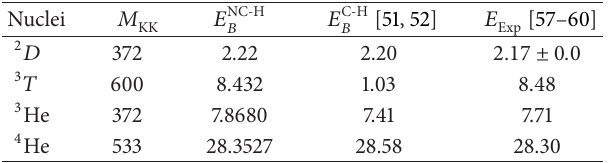
Table 7: The obtained binding energy of 2 D, 3 T, 3 He, and 4 He nuclei with 𝑁 𝑐 = 3 and 𝑚 𝑁 = 0.92 GeV. The results have a good consistency with the experimental nuclear data. All energies are in